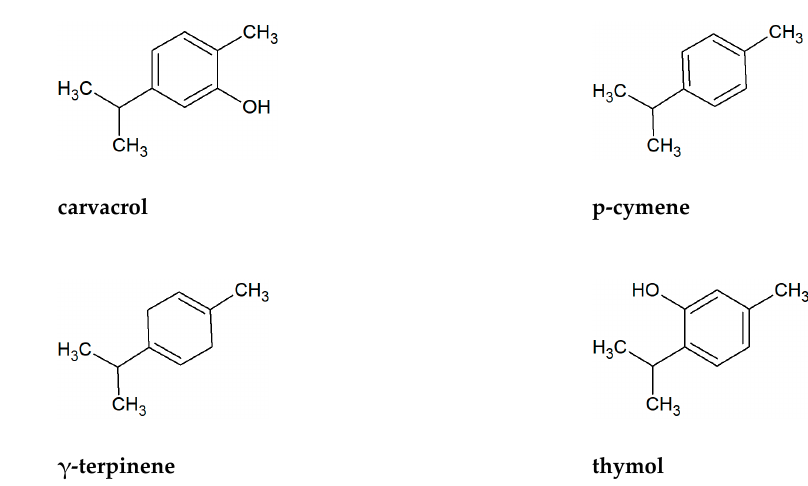
Figure 2. Chemical formulas of ten substances the most commonly found in essential oils of Lamiaceae plants presented in Table